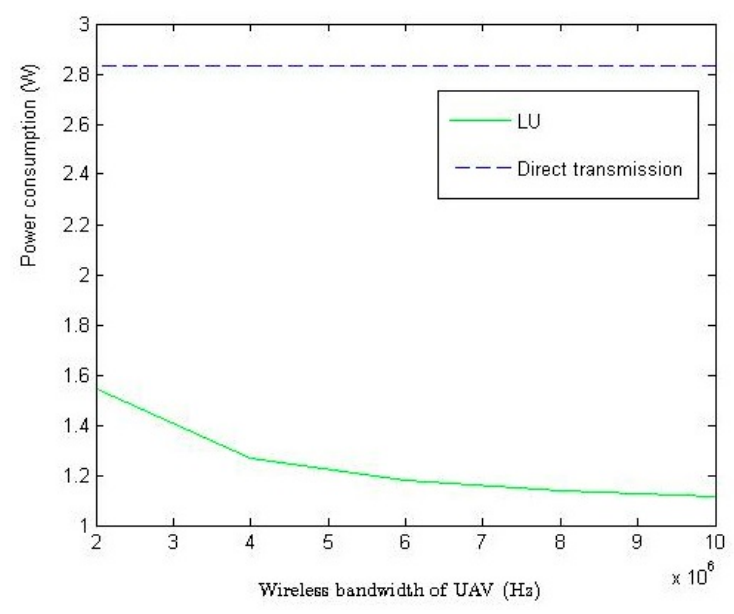
Figure 5. The impact of B U on system power consumption (how to cut down the power consumed in system by increasing wireless bandwidth of UAV (Hz)).